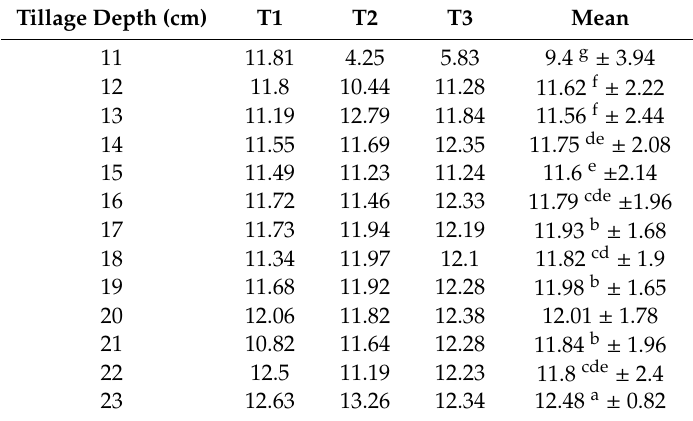
Table 9. Descriptive statistics of front axle power (kW) according to tillage depth.